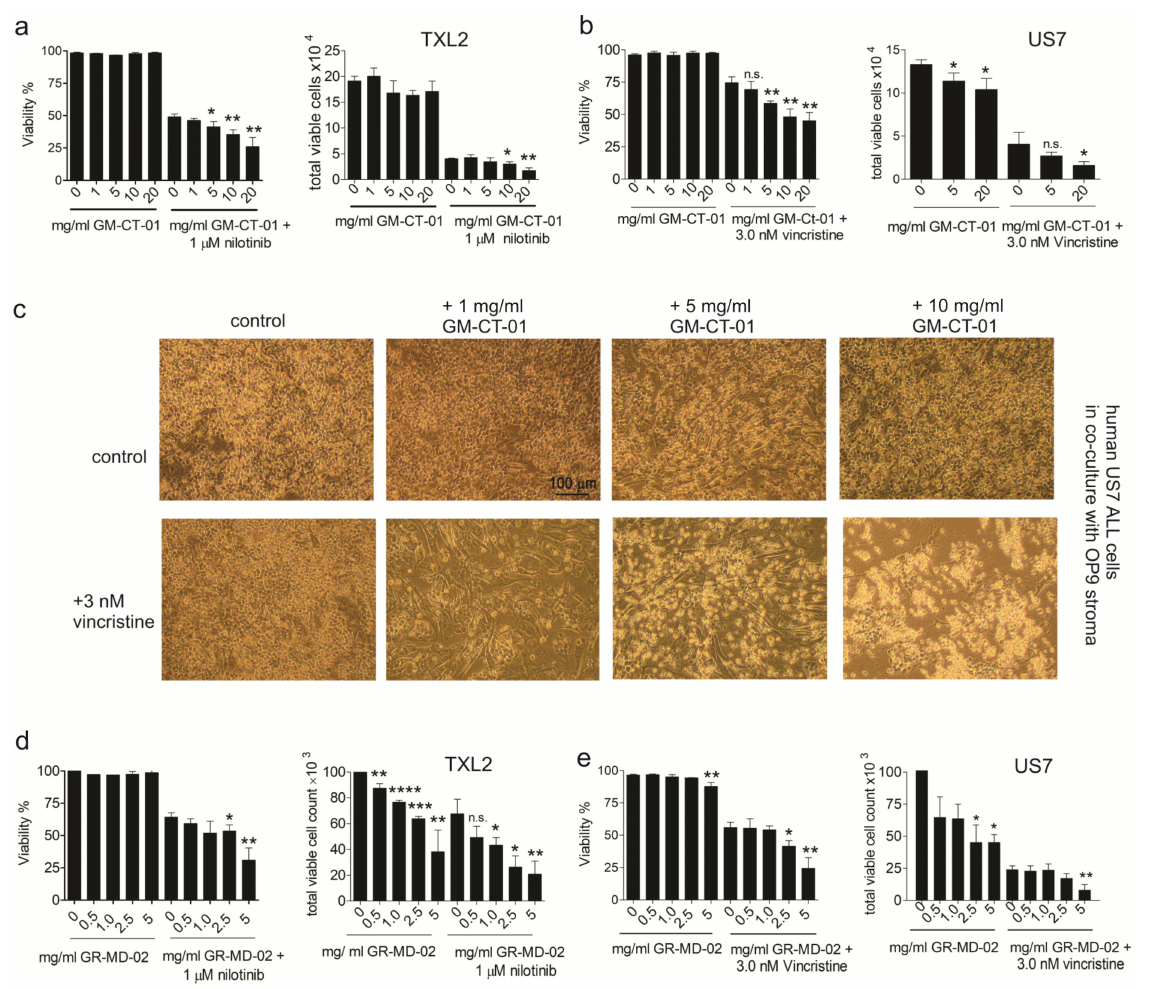
Figure 4. Combination drug treatment with GM-CT-01 or with GR-MD-02 inhibited proliferation of ALL cells. ( a ) Viability (left panel) and cell counts (right panel) of Ph-positive TXL-2 BCP-ALL cells treated with GM-CT-01 and nilotinib for 96 h in the presence of OP9 cells. ( b ) Viability (left panel) and cell counts (right panel) of US7 cells treated for 96 h with GM-CT-01 alone or in combination with vincristine in the presence of OP9 cells. ( c ) Phase contrast images of US7 cells co-cultured with irradiated OP9 stroma and treated with GM-CT-01 and vincristine as indicated. ( d , e ) Viability and cell counts of TXL2 ( d ) or US7 ( e ) treated with GR-MD-02 or a combination treatment as indicated. Viable cells and cell numbers were determined using Trypan blue exclusion. * p < 0.05, ** p < 0.01, *** p < 0.01, **** p < 0.0001 compared to 0 mg/mL samples, representing treatment with nothing or only with nilotinib or vincristine, unpaired t -test. Control samples, DMSO at the same final concentration as the vincristine/nilotinib